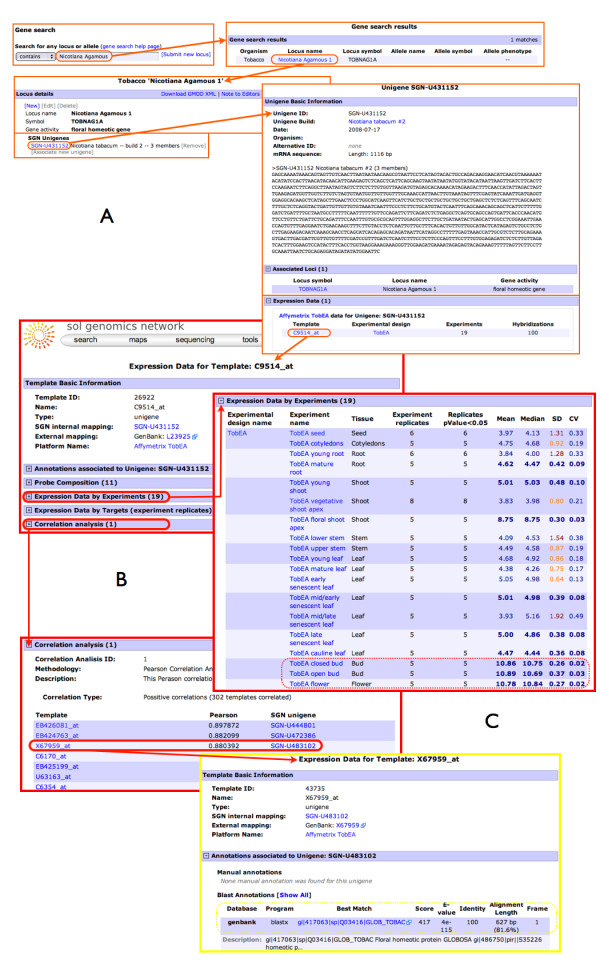
Data access using SEDM (SGN Expression Data Module). Screen shots summarising user access to expression data via the SGN Expression Data Module. Data is available to users from a direct search or via from a search of another SGN element (A). The expression data is shown in the template page with data about the probes, annotation and correlation analysis associated (B). The correlation analysis section can be used to access to other probe-sets with similar expression across the TobEA microarray dataset (C).